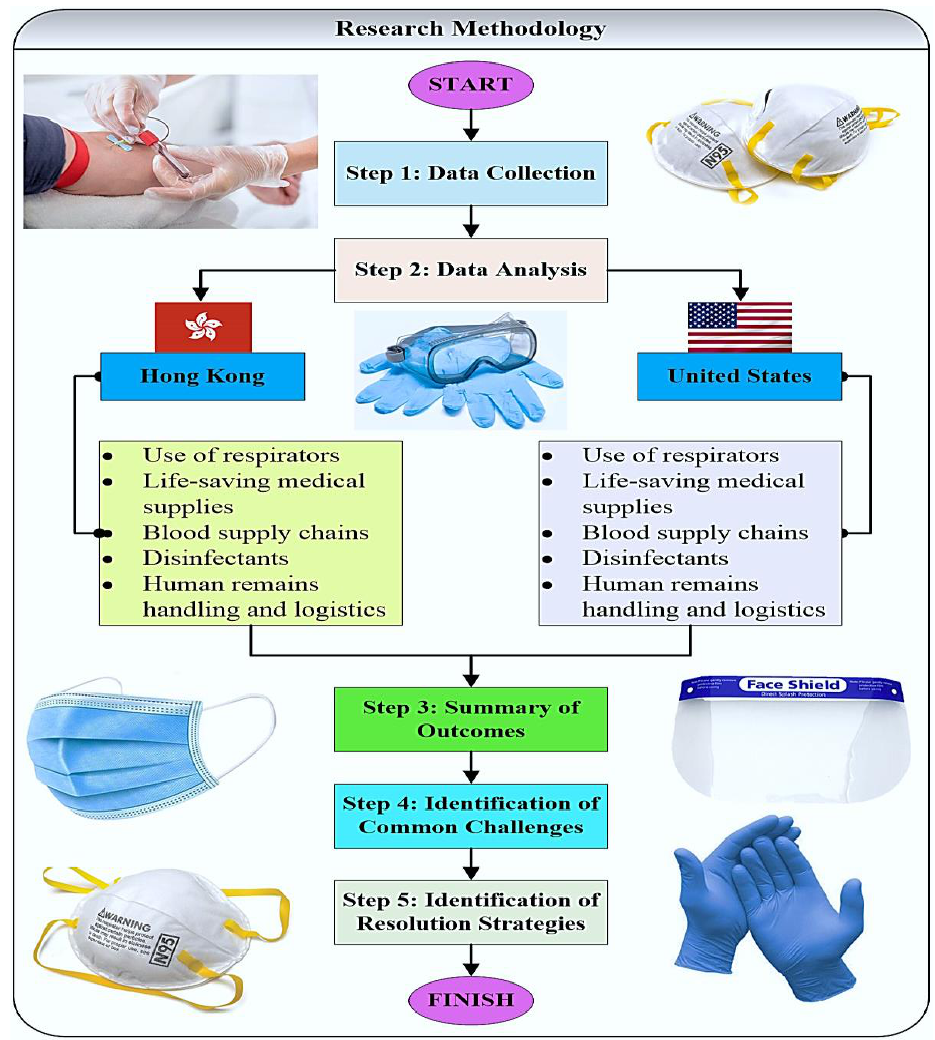
Figure 1. The mains steps of the adopted research methodology.